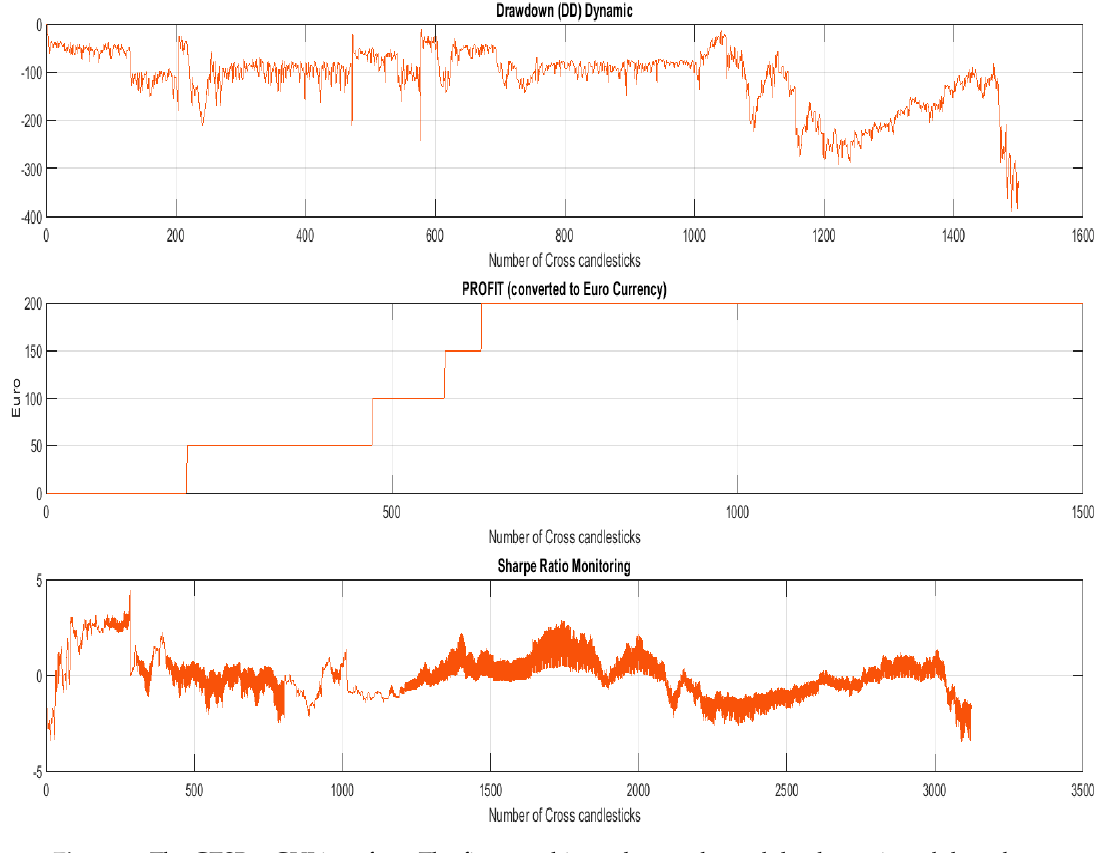
Figure 7. The GTSBot GUI interface. The first graphic on the top showed the dynamic real drawdown of the financial account. The second diagram showed the total profit being obtained. The third diagram showed a financial indicator known as the Sharpe ratio [12] that we used for monitoring financial dynamic of the trend.